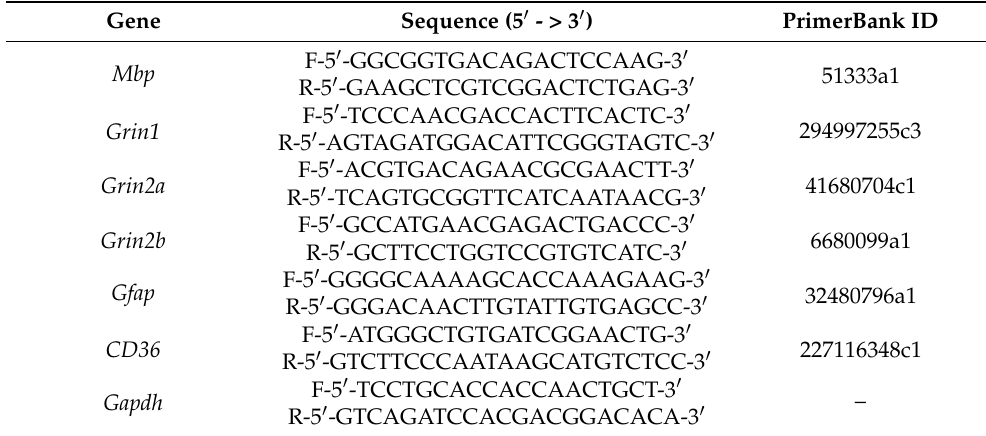
Table 1. Primer sequence.